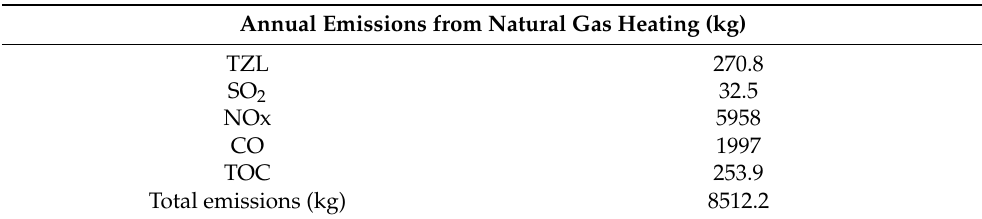
Table 3. Calculation of emissions from natural gas heating.